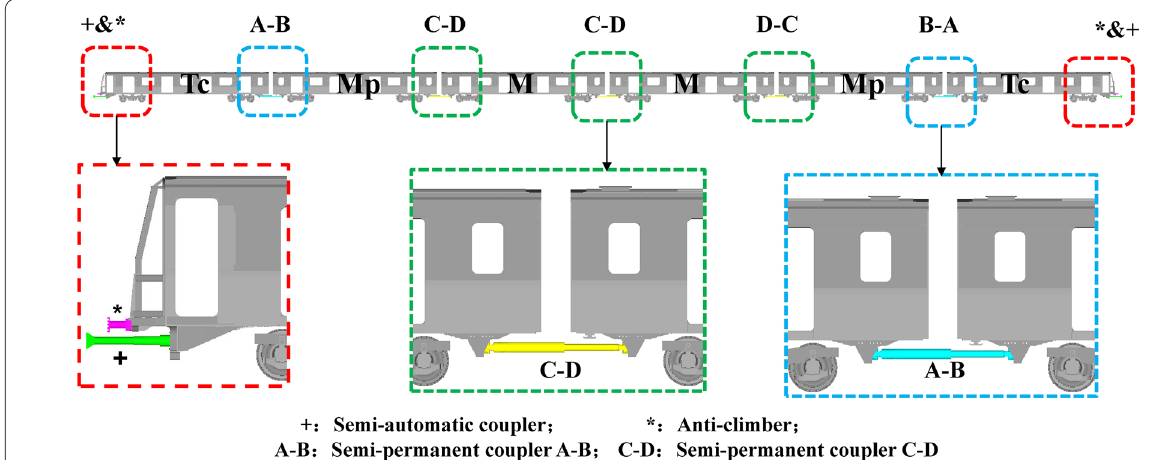
Figure 1 Energy absorption devices and layout of a typical B-type subway train